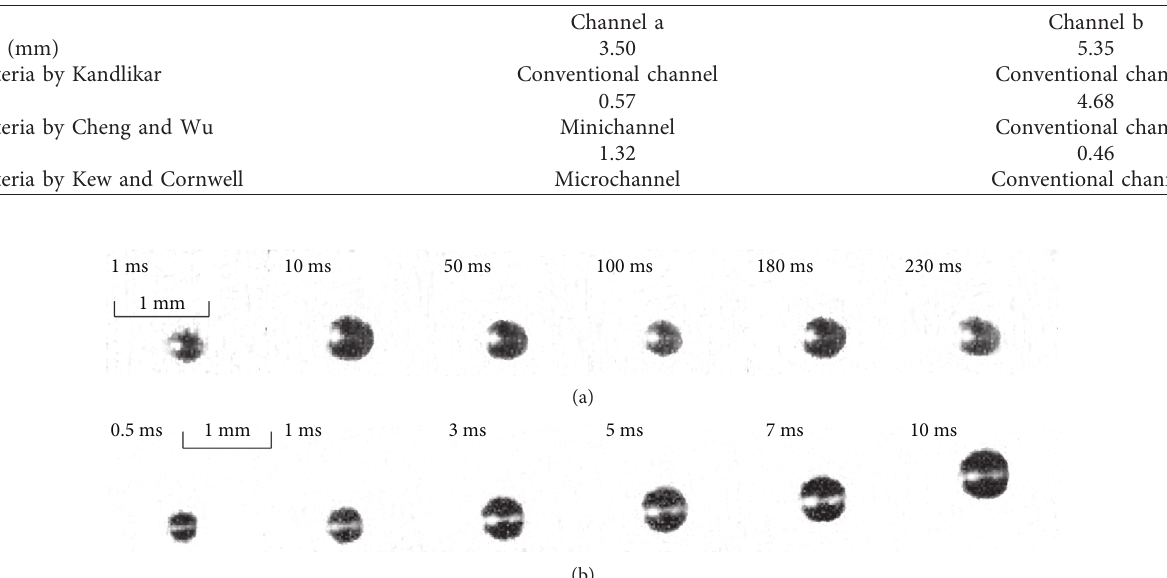
: 90 ° C, G : 100kg/(m 2 · s), p:1000W. (b) T in